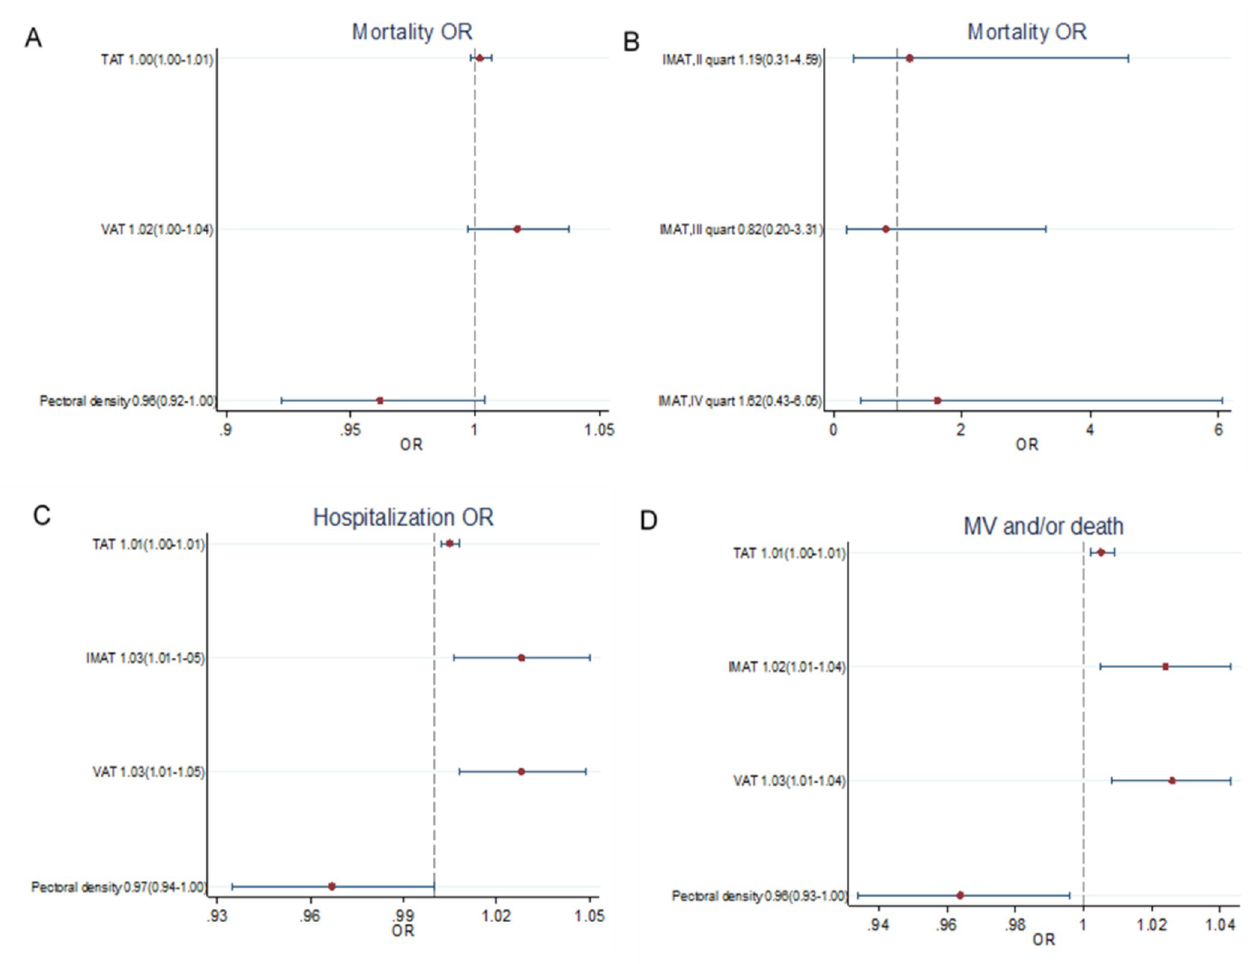
Fig 2. Multivariate logistic models adjusted for sex, age, and calendar period (weeks since the beginning of the outbreak). A) Mortality OR for unit increase with 95% CI for unit increase of pectoral muscle density (HU), VAT (cm 2 ), and TAT (cm 2 ). B) Mortality OR with 95% CI for IMAT quartiles (cm 2 ). C) Hospitalization OR with 95% CI for unit increase of pectoral muscle density (HU), VAT (cm 2 ), IMAT (cm 2 ), and TAT (cm 2 ). D) Mechanical ventilation and/or death OR with 95% CI for unit increase of pectoral muscle density (HU), VAT (cm 2 ), IMAT (cm 2 ), and TAT (cm 2 ). OR, Odds Ratio; CI, Confidence Interval; TAT, total adipose tissue area; VAT, visceral adipose tissue area; IMAT, intermuscular adipose tissue area.